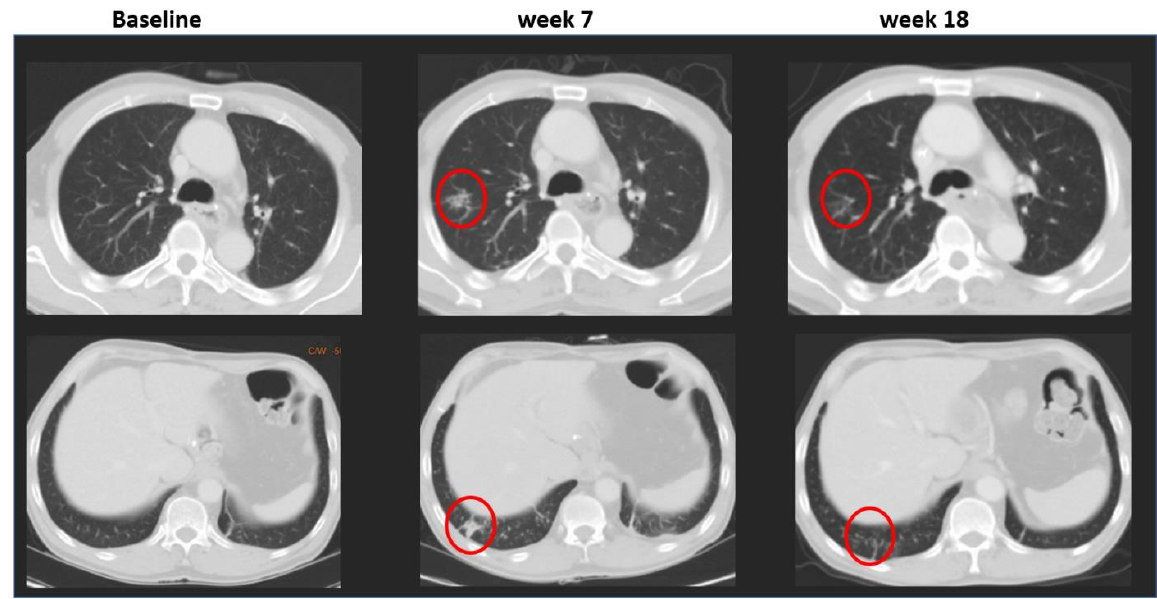
Figure 4. New micro- or ground-glass lesions. Multiple new lung nodules marked in red circles (partial solid or ground-glass opacities) appeared in week 7, were determined as equivocal in the same week, and resolved in week 18.